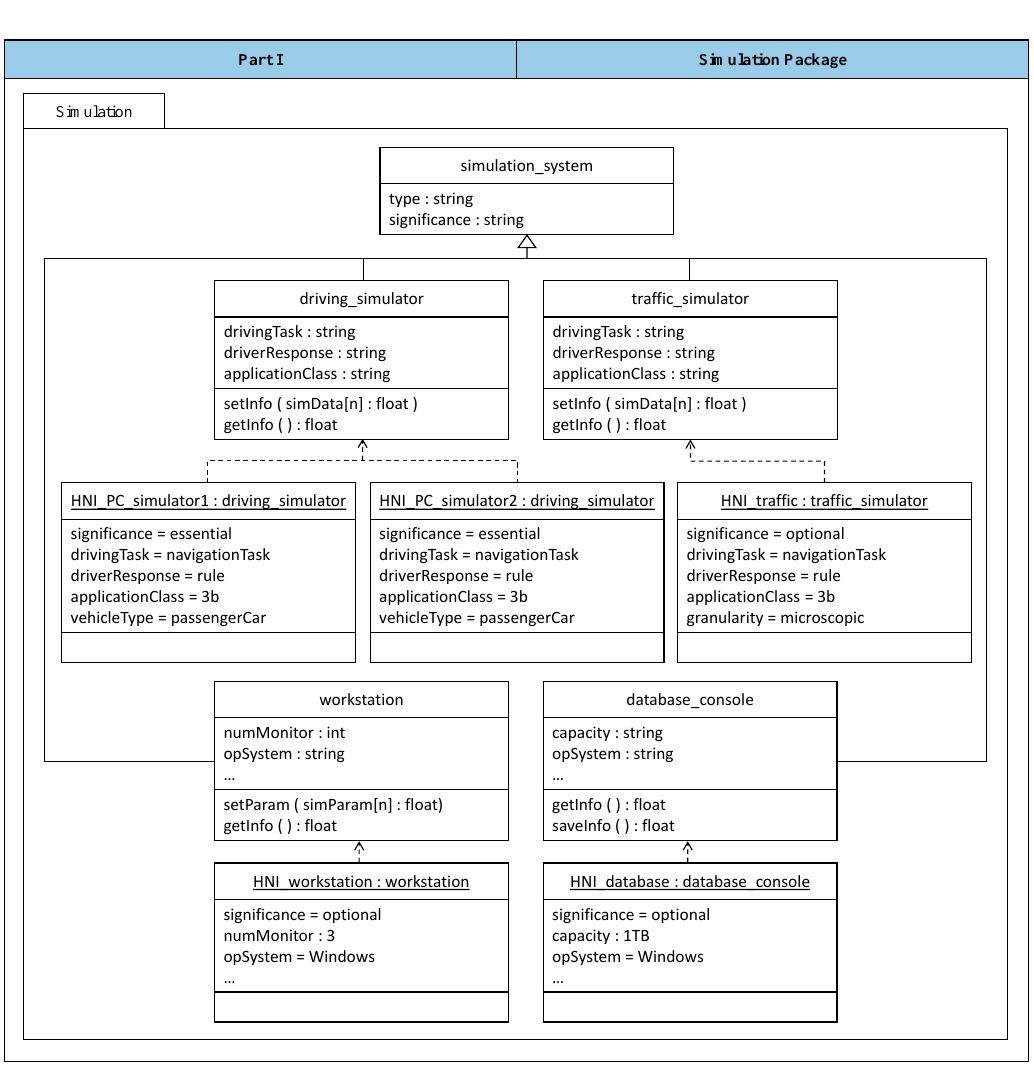
Figure 19. UML class diagram of the selected simulation system components—package 1.